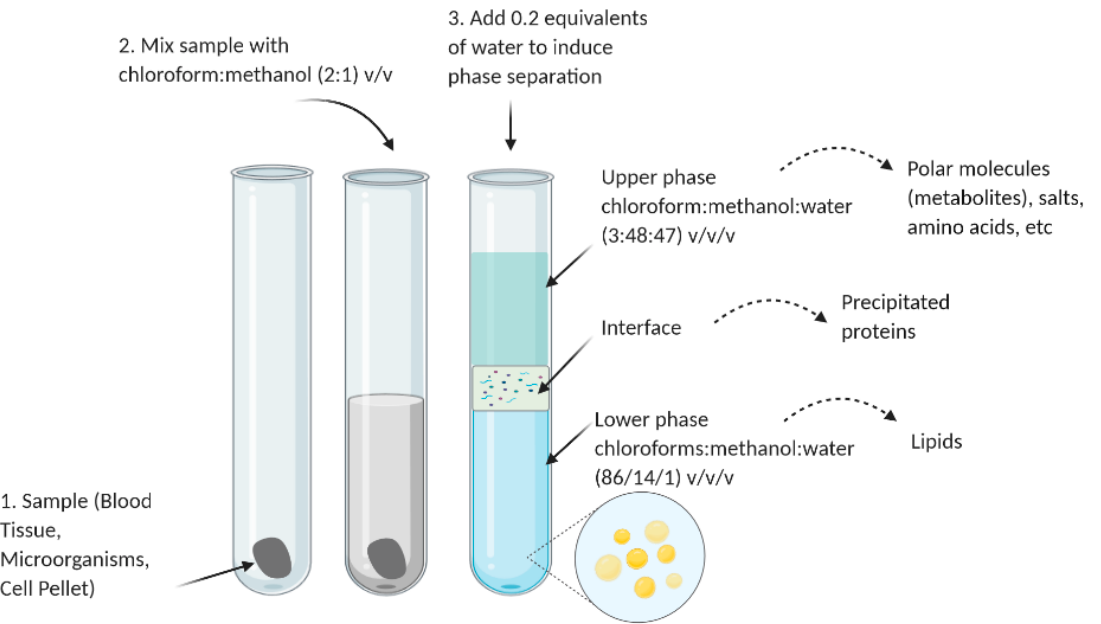
Figure 3. Representation of Folch’s extraction method